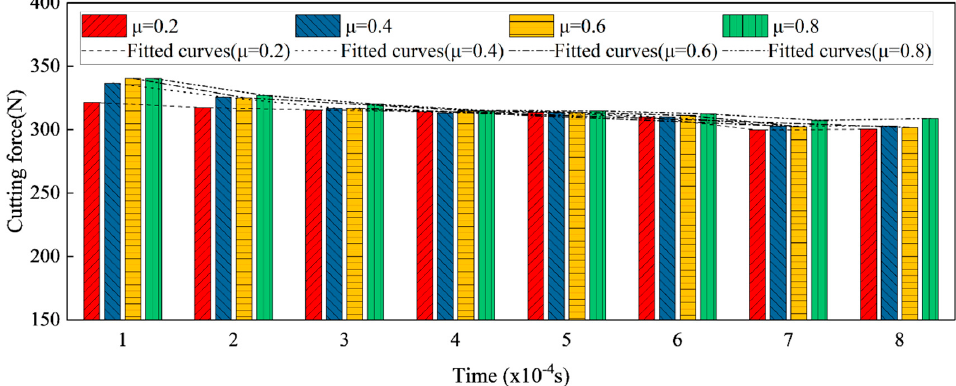
Figure 11. Comparisons of cutting forces with − 25 ◦ chamfer tool under different friction coe ffi - cient.